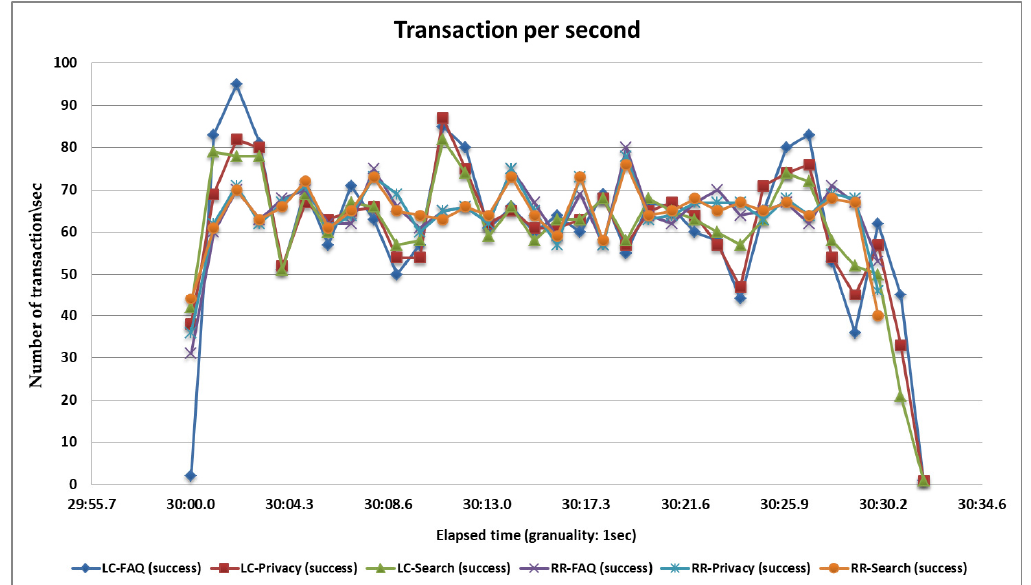
Figure 19. Throughput or transactions per second of the RR and LC algorithms.